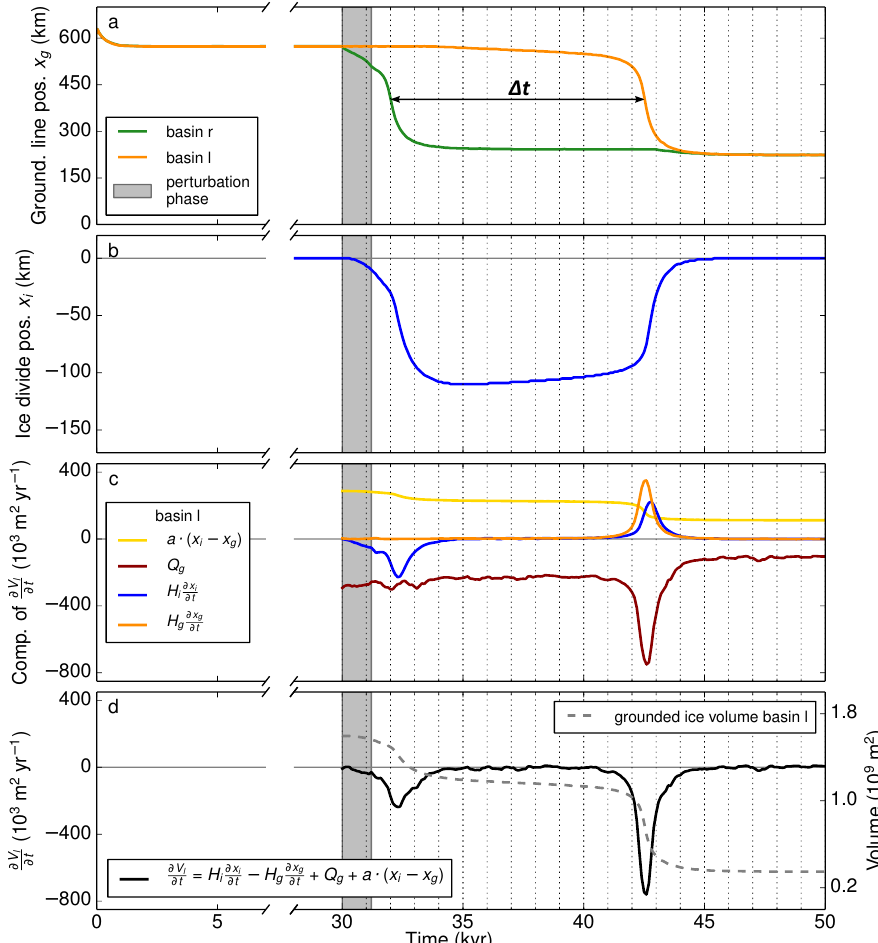
Figure 5. Time series for the unstable scenario U (simulation BC0, see Figs. 3a and 4a) of (a) the absolute value of the grounding line positions (b) the position of the ice divide (as defined in the text), (c) the individual components of ∂V l with a 500-year moving window), (d) the sum of these components and the grounded ice volume of basin l. The transition time (cid:49)t , used in Eqs. (8)–(10), is depicted by a double-headed arrow in (a)